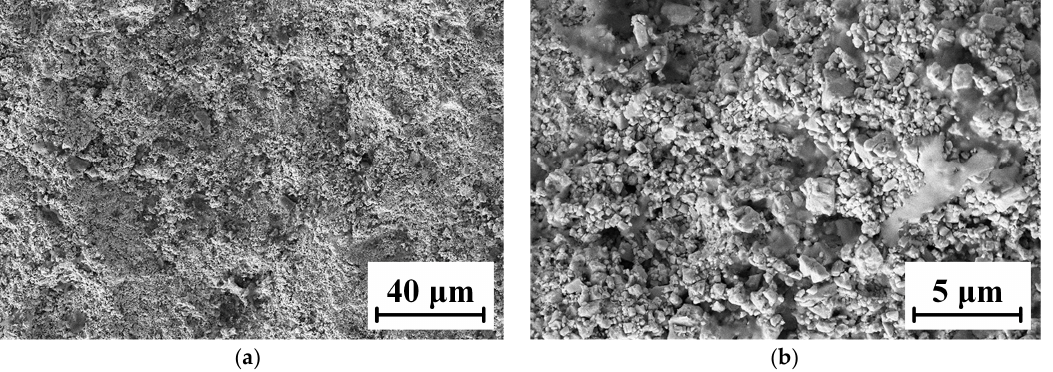
Figure 10. Micro-morphology of the WC-12Co coating surface. ( a ) The surface morphology of the coating at 1 K times magnification; ( b ) The surface morphology of the coating at 5 K times magnification